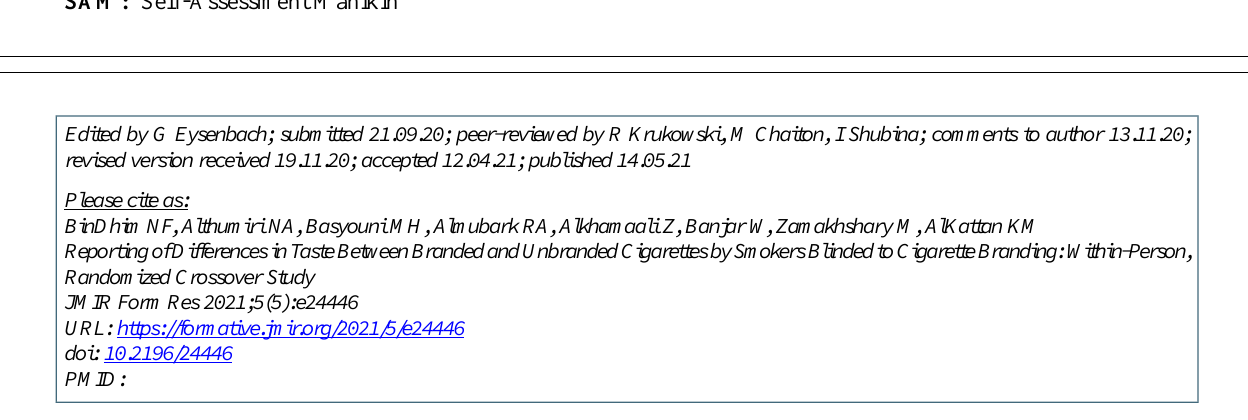
BWS: Brief Worry Scale about Smoking SAM: Self-Assessment